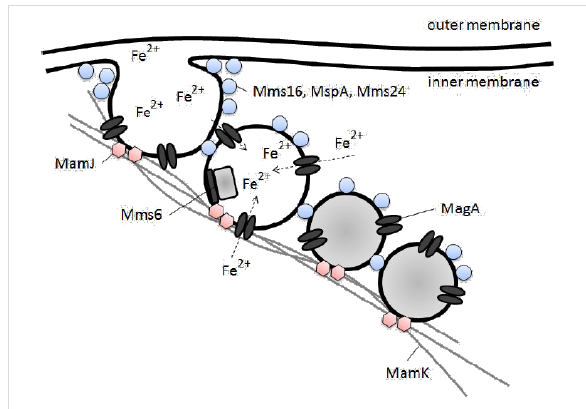
Figure 5: Hypothesized particle formation during the biomineralization process in magnetotactic bacteria (in analogy to